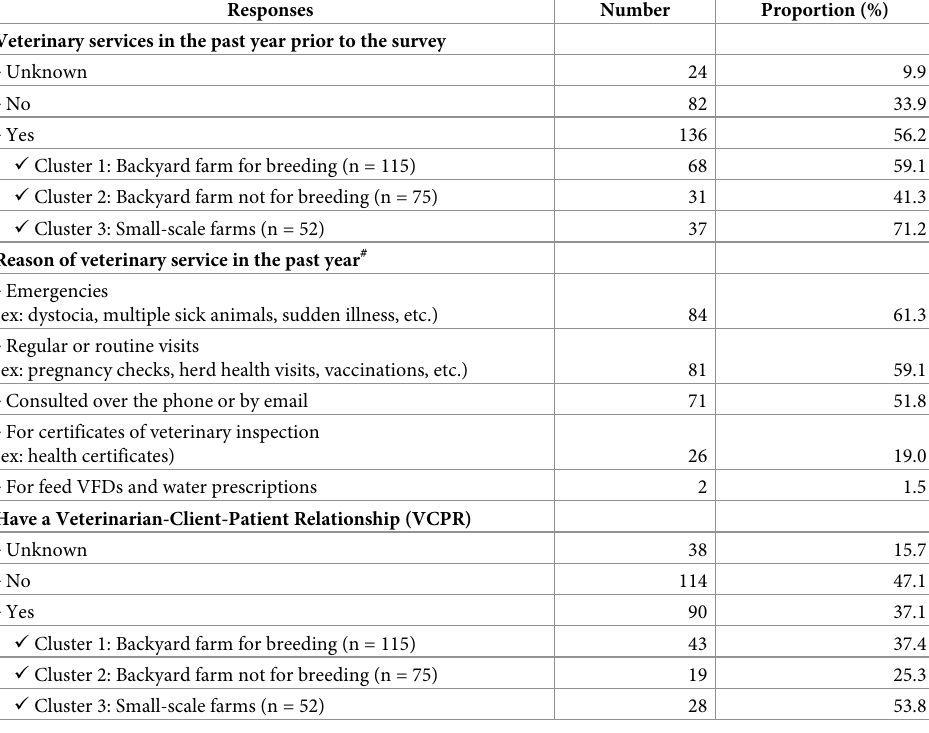
Table 3. Summary of veterinary service use by survey respondents (n =